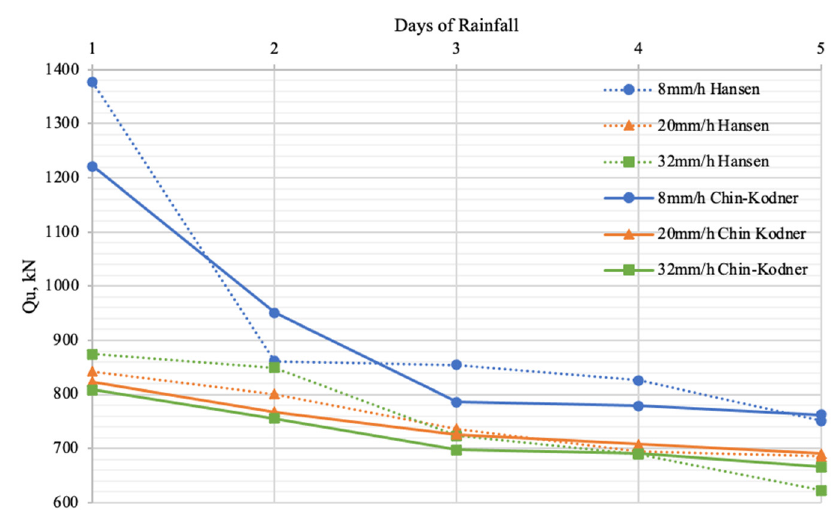
Figure 11. Estimation of soil bearing capacity.